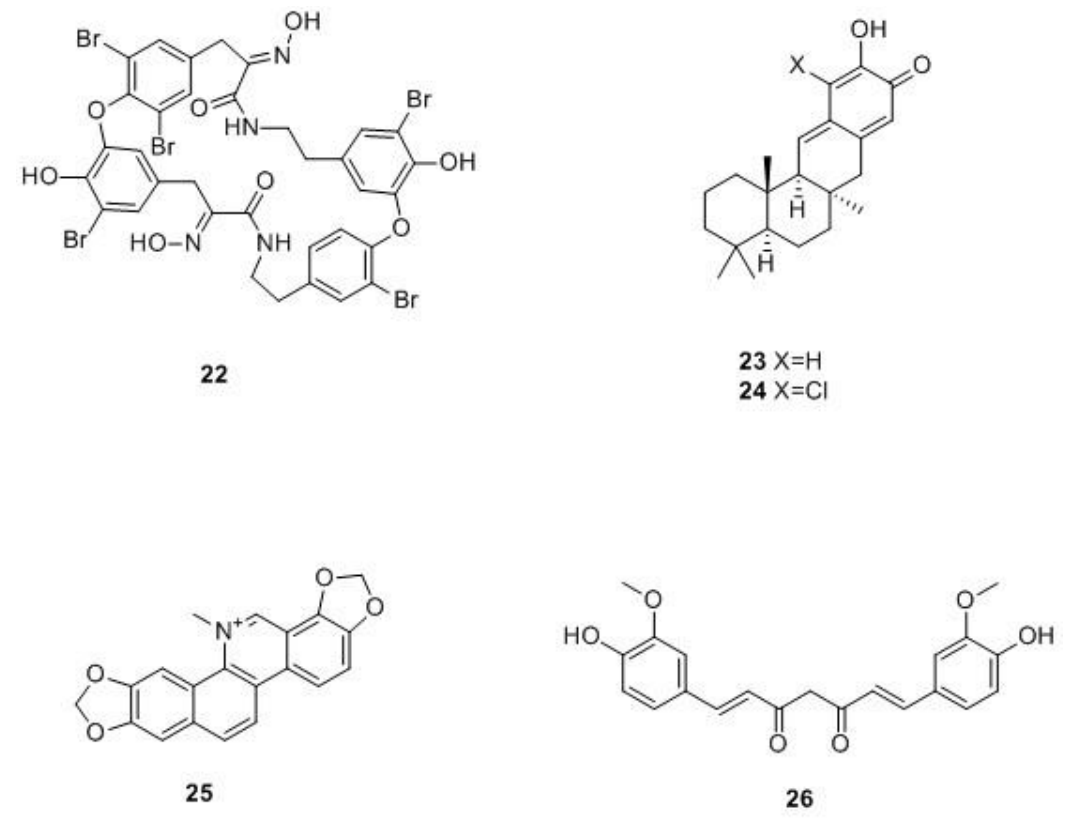
Figure 11. Natural compounds active against the DHFR enzyme.